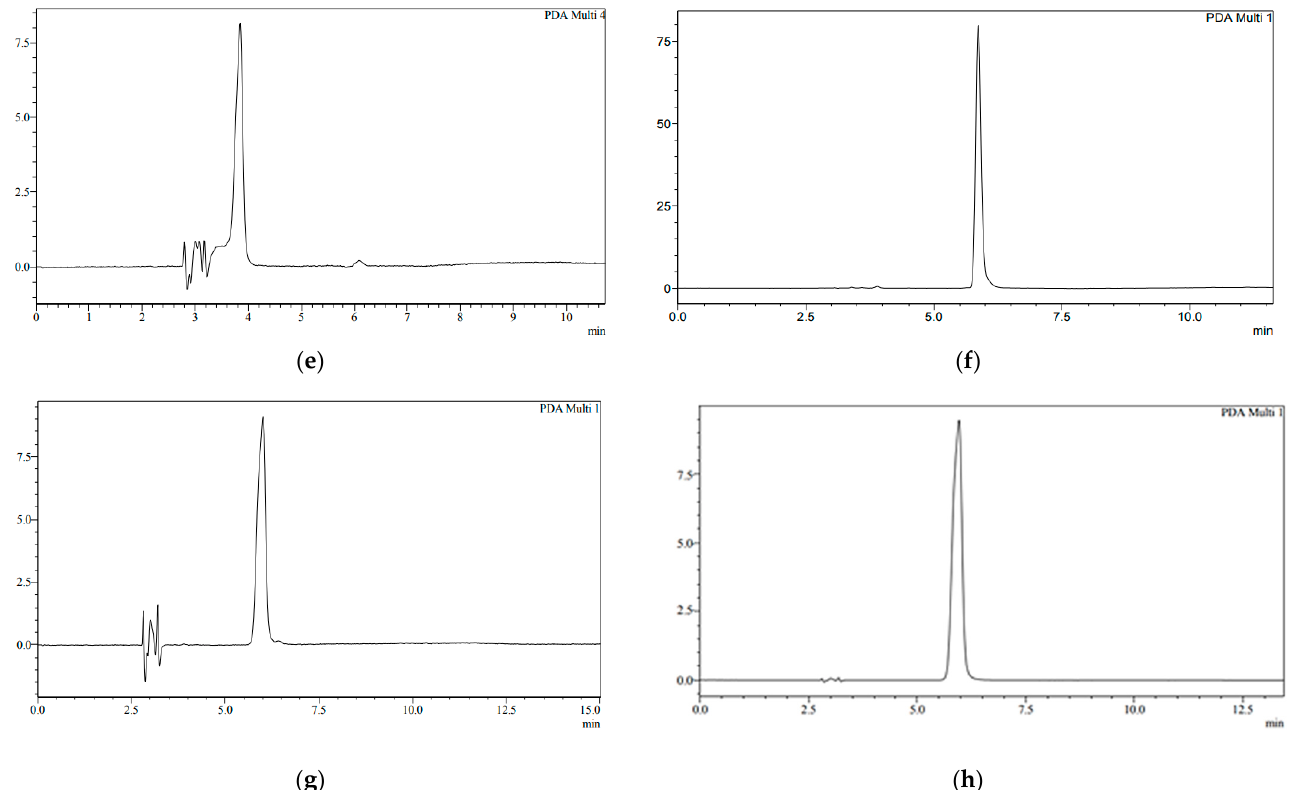
Figure 5. HPLC chromatograms of individual purified biologically active substances. ( a ) Quercetin; ( b ) luteolin; ( c ) isorhamnetin; ( d ) kaempferol; ( e ) ginkgolide A; ( f ) ginkgolide B; ( g ) ginkgolide C; ( h ) bilobalide A.